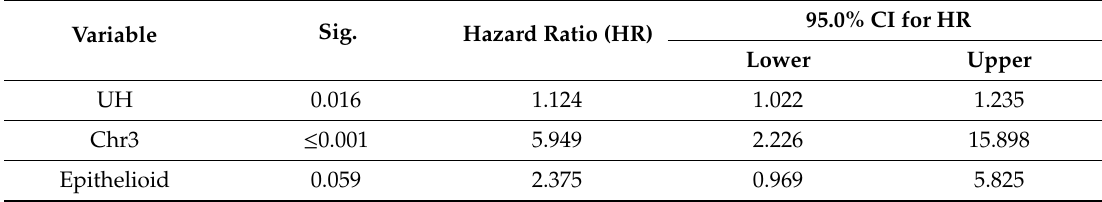
Table 3. Multivariate analysis of n = 117 UM patients treated at Liverpool Ocular Oncology Centre.